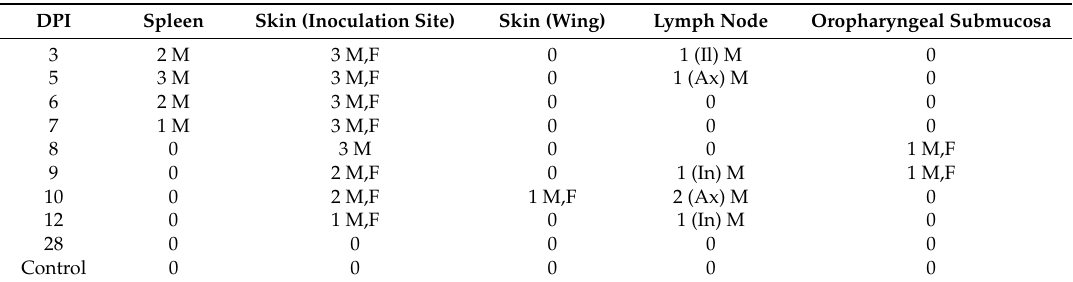
Table 2. Immunohistochemistry results a for tissues other than liver, for Egyptian rousette bats ( Rousettus aegyptiacus ) experimentally infected with Marburg virus in a serial euthanasia study. DPI Spleen Skin (Inoculation Site) Skin (Wing) Lymph Node Oropharyngeal